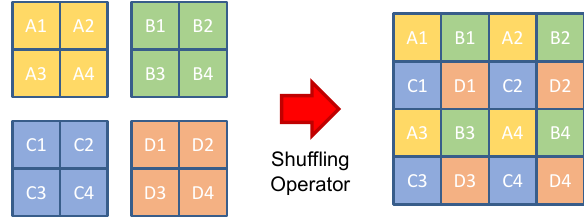
Figure 4. Basic concept of the shuffling operator: it converts c × u 2 feature maps of size H × W into c feature maps of size ( H × u ) × ( W × u ) . Here: H = 2 , W = 2 , u = 2 , c = 1